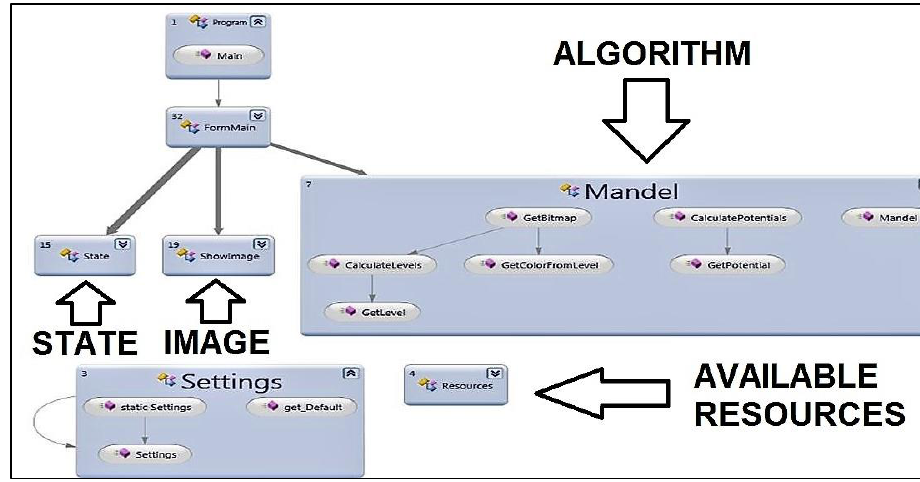
Figure 4. Mandelbrot Class Architecture — Main class.